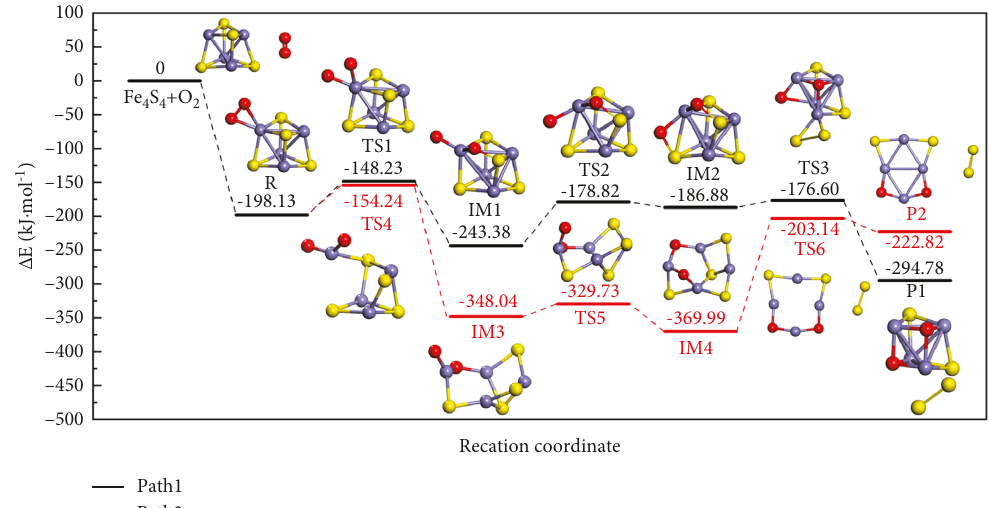
Figure 6: The stage 1 reaction path of Fe 4 S 4 clusters with O 2 on the nine-fold state potential energy surface.